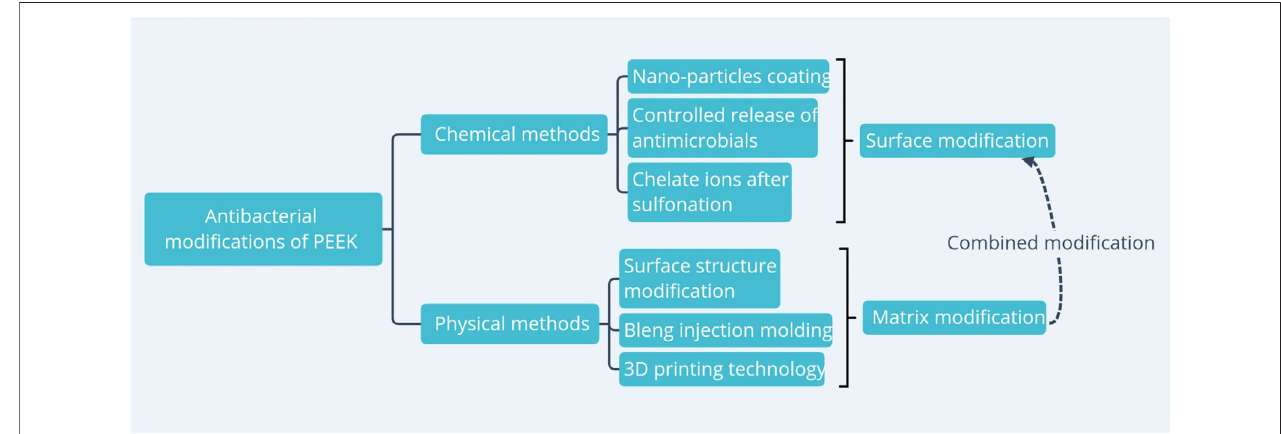
FIGURE 2 | Current research on biofunctionalized PEEK with